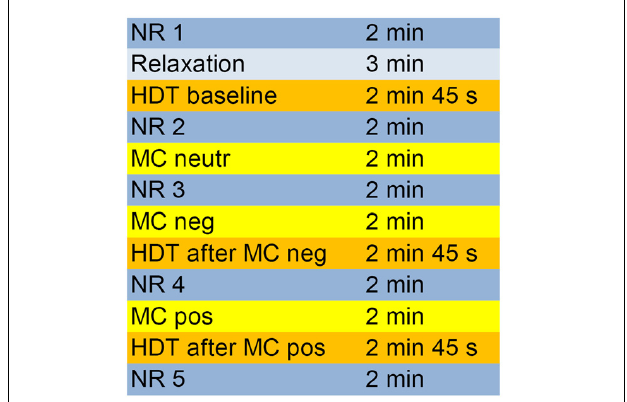
FIGURE 1 | Course of the different measurement phases of the experiment. HDT, heartbeat detection task; MC, mirror-confrontation; NR, neutral reference (imagining washing the dishes); neutr, neutral (no cognitive accompaniment); neg, negative (with negative cognitive accompaniment); pos, positive (with positive cognitive